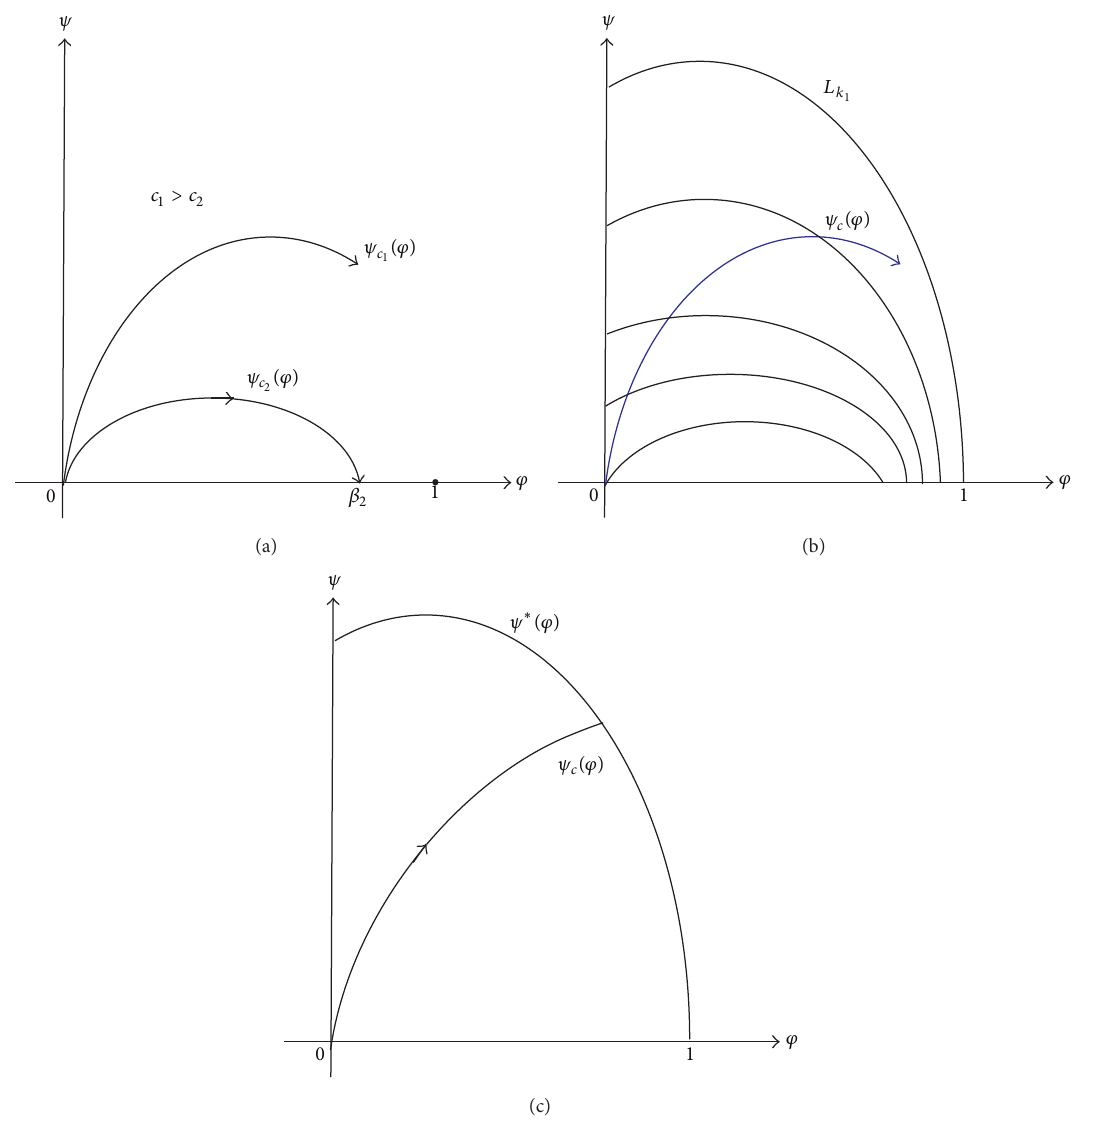
Figure 3: The properties of the trajectory 𝜓 𝑐 (𝜑) . (a) The monotonicity of 𝜓 𝑐 (𝜑) on 𝑐 . (b) The trajectory 𝜓 𝑐 (𝜑) wanders through 𝐿 𝑘 . (c) The trajectory 𝜓 𝑐 (𝜑) intersects with 𝜓 ∗ (𝜑) for large 𝑐